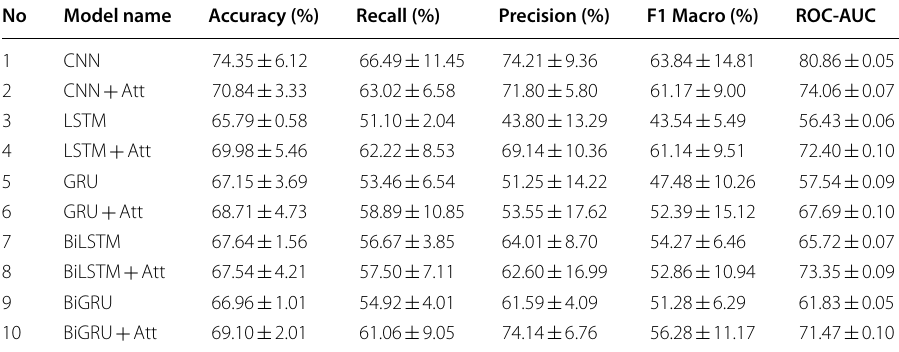
Table 6 Result of argument analysis using deep learning model with attention mechanism (Word Embedding from Scratch)